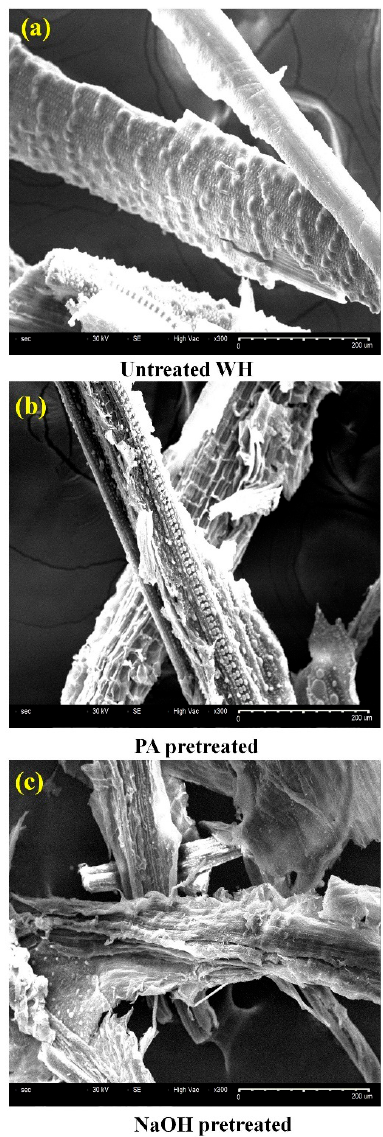
Figure 3. Scanning electron microscopy (SEM) micrographs of ( a ) untreated WH, ( b ) peracetic acid (PA) pretreated and ( c ) NaOH pretreated WH biomass under optimized conditions. This may be because of significant delignification and hemicellulose solubilization of biomass enhancing enzymatic accessibility.